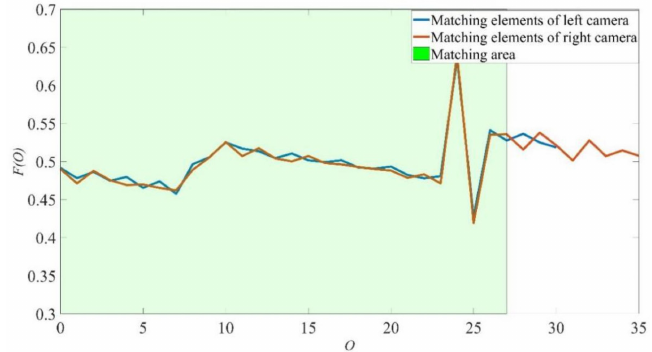
Figure 13. Feature-point-matching